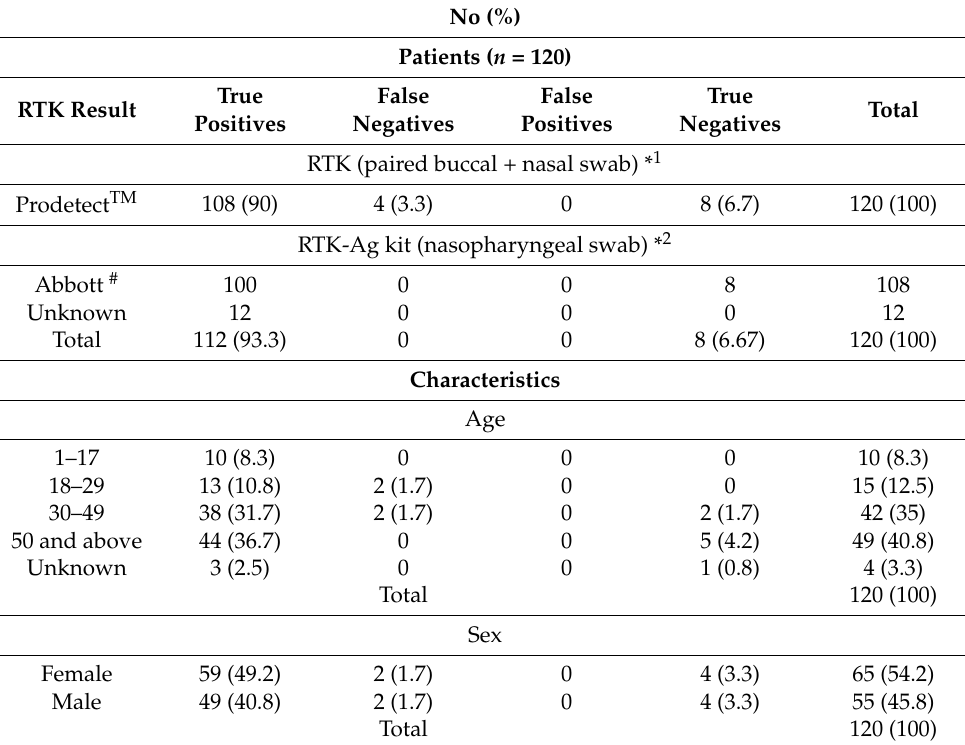
Table 1. Baseline demographic of the patients and the results of nasopharyngeal swab and paired nasal and oral